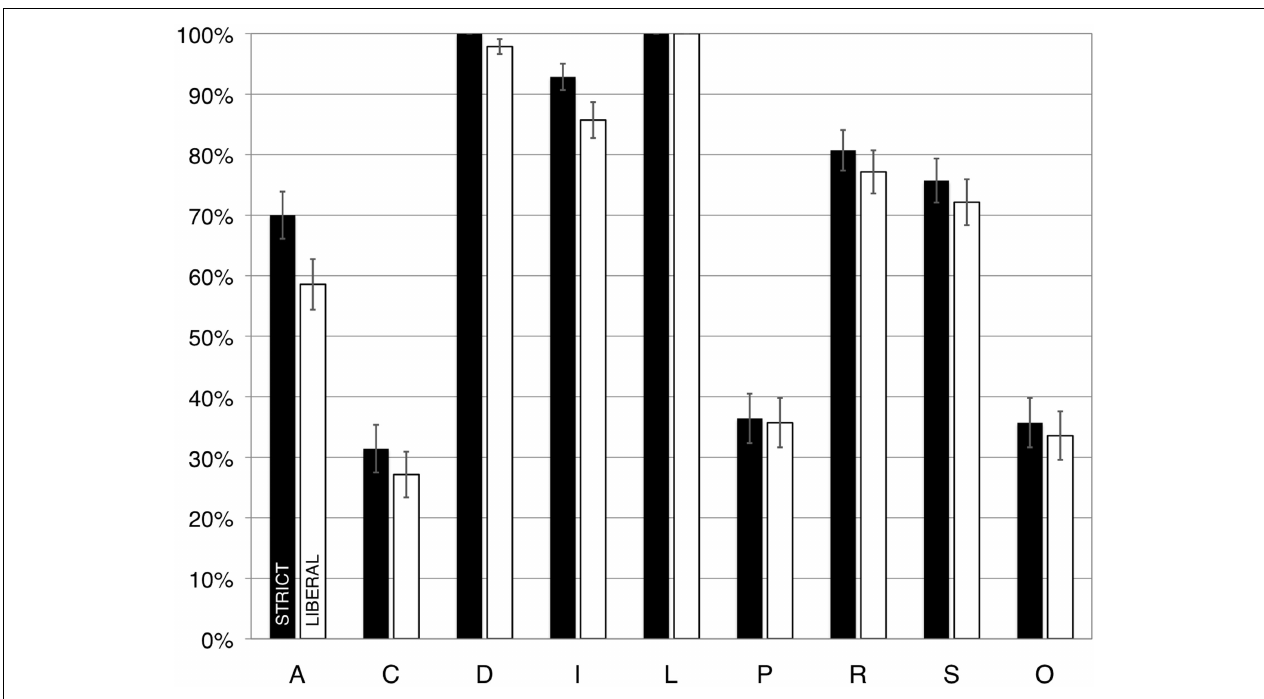
change; L, limited capacity; P, perceptual organization; R, relevance; S, salience; O, over-determined. Error bars illustrate the standard error of the